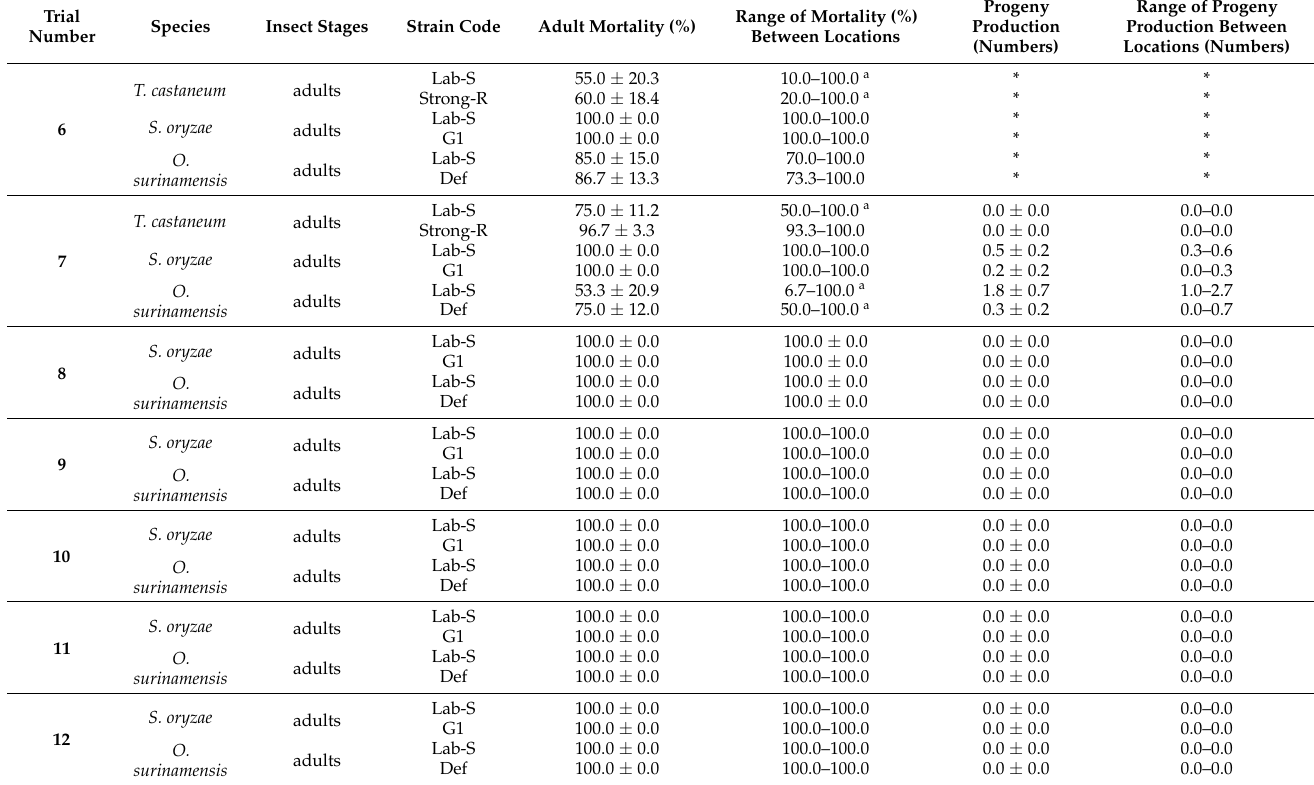
Table 4. Mean mortality (% ± S.E.) of four populations of T. castaneum (Lab-S, D1, Strong-R-TC), four populations of S. oryzae (Lab-S, G1), and two populations of O. surinamensis (Lab-S, Def) with different susceptibility to phosphine exposed to nitrogen, and progeny production (mean number of adults ± S.E./vial) 65 d later (* asterisk indicates that progeny production was not counted). For each treatment, no significant differences were recorded among the resistant and susceptible populations ( a indicates significant differences among locations and populations in each